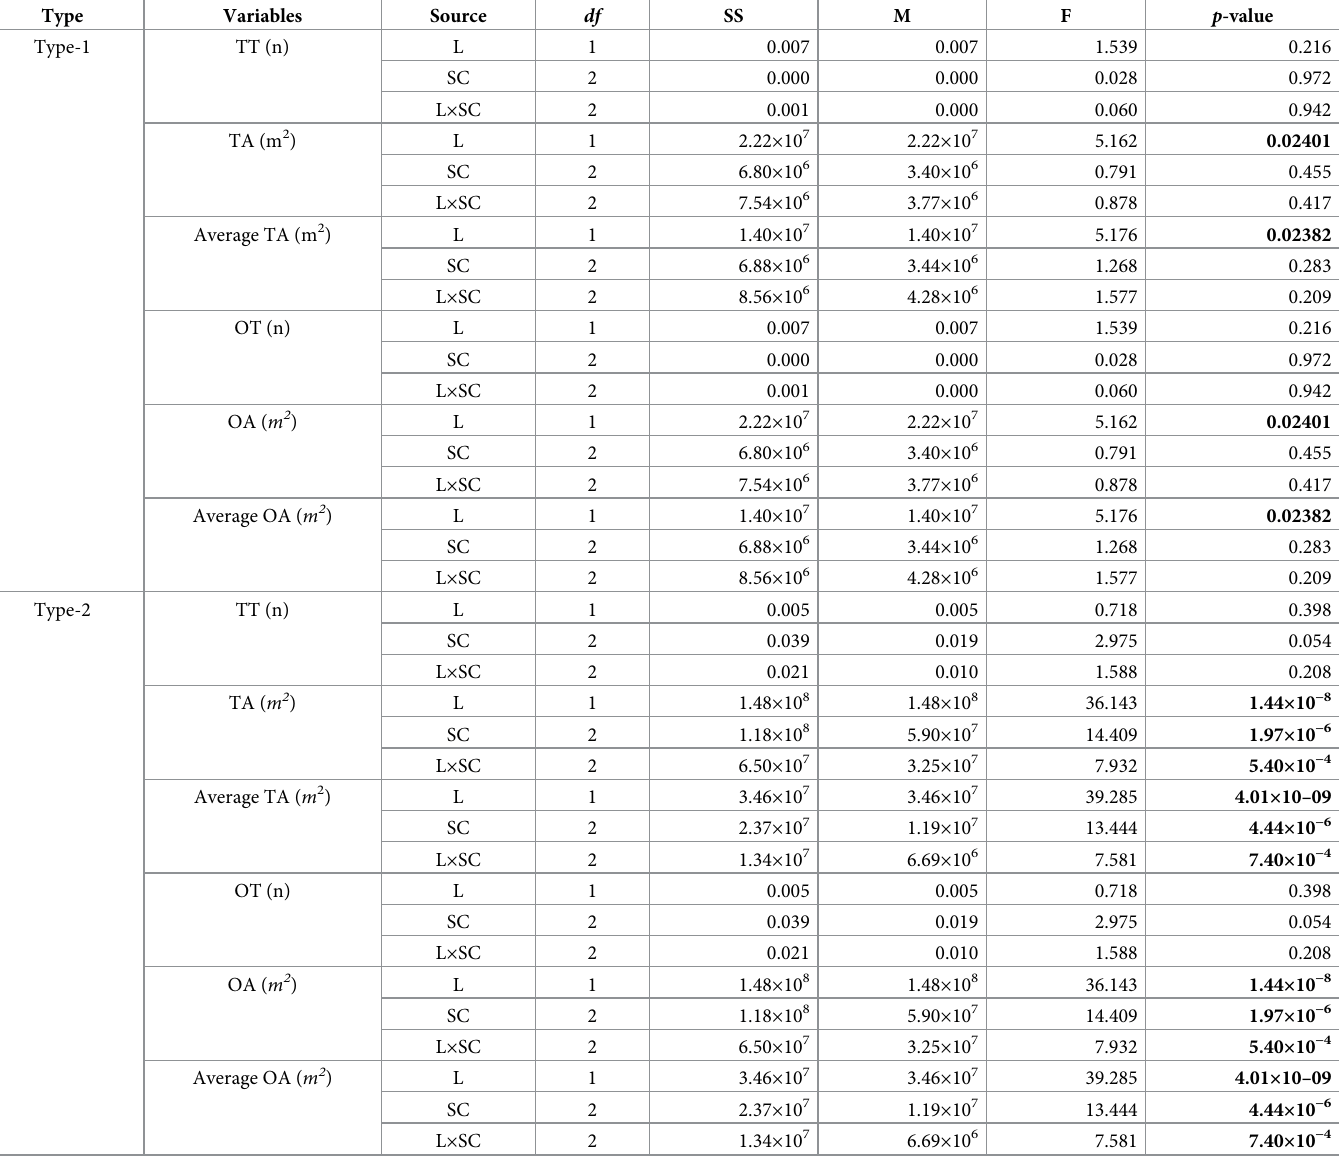
Table 4. Relationships between school location and school category and